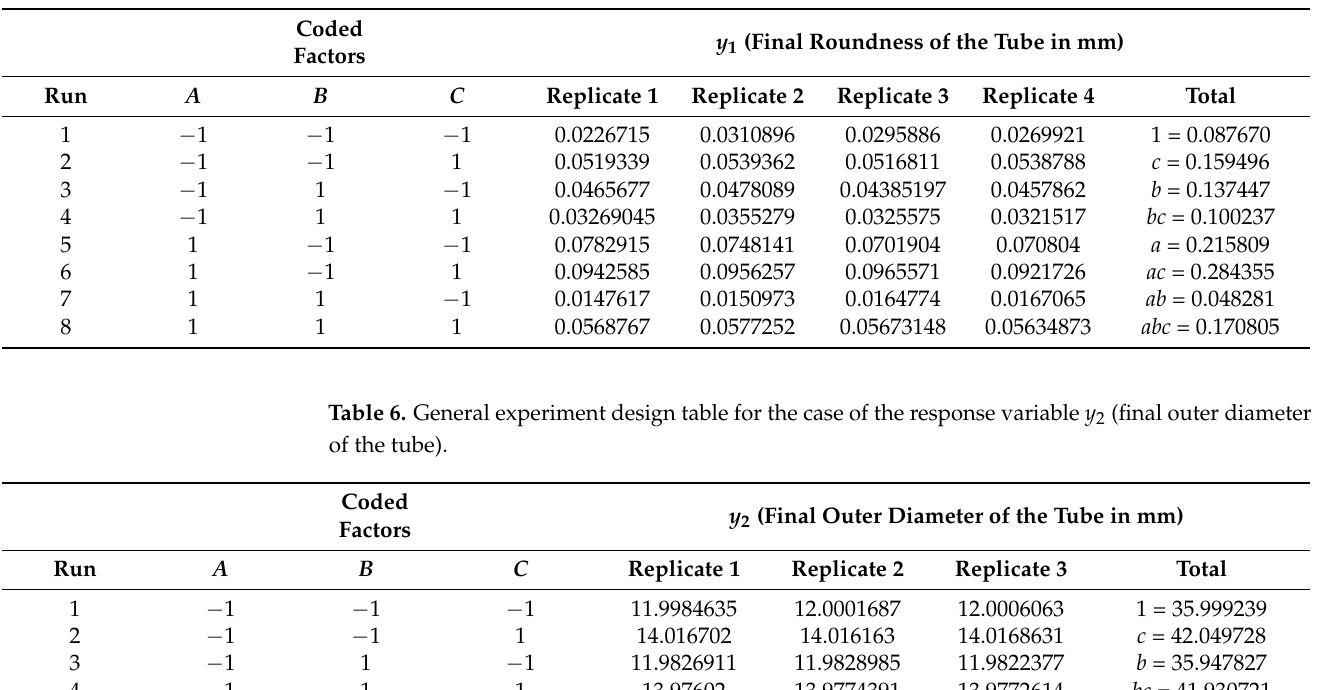
Table 5. General experiment design table for the case of the response variable y 1 (the roundness of the tube).